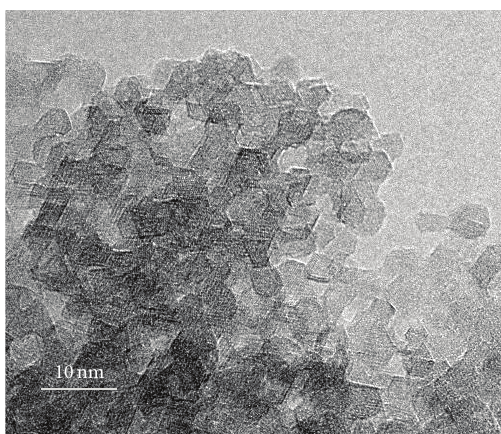
Figure 3: TEM image of the faceted nanocrystals observed in the green-emitting phosphor ( x = 10 . 0 at % Eu ) powder produced by RIRO.